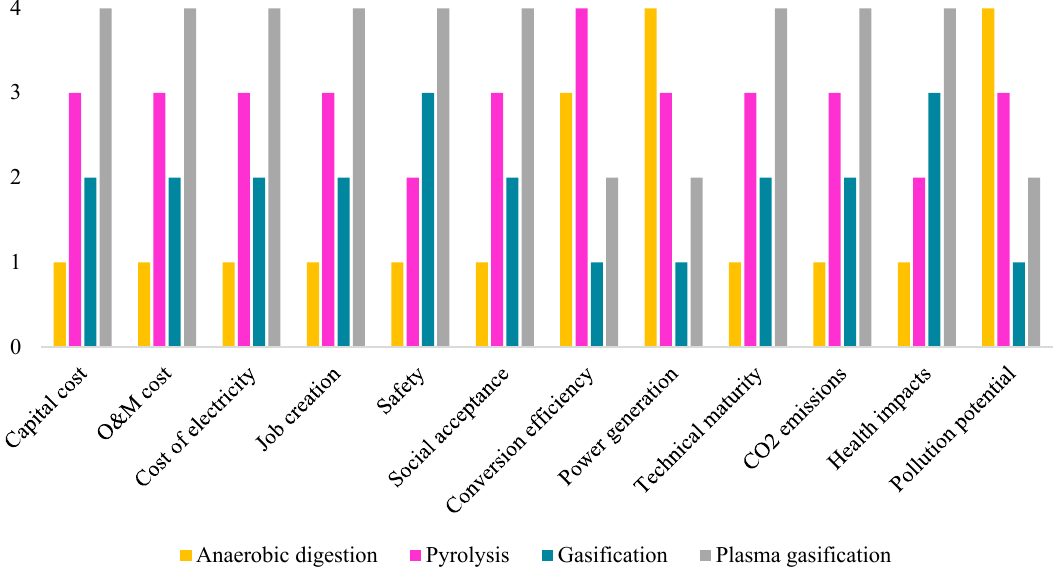
Figure 12. Ranks of the WtE technologies with regard to the evaluation criteria.